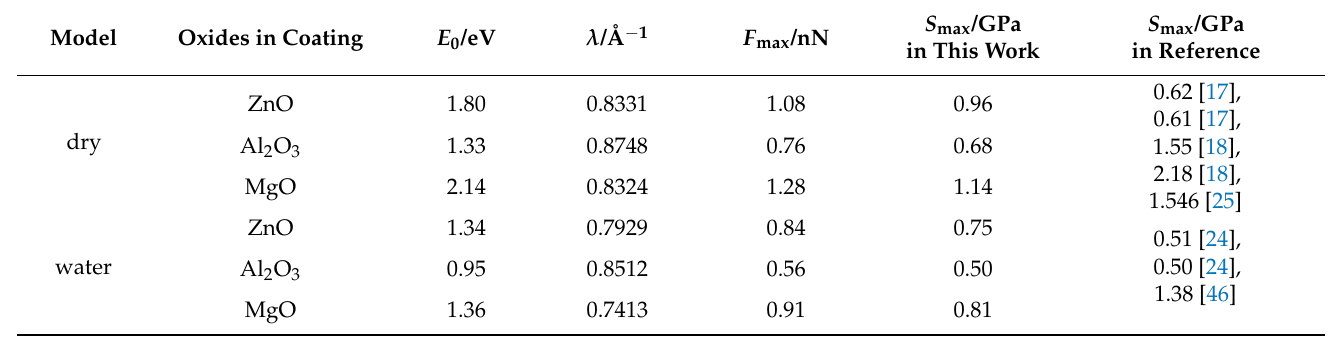
Table 2. Theoretical adhesion properties and fitting parameters for the dry and water surface models.